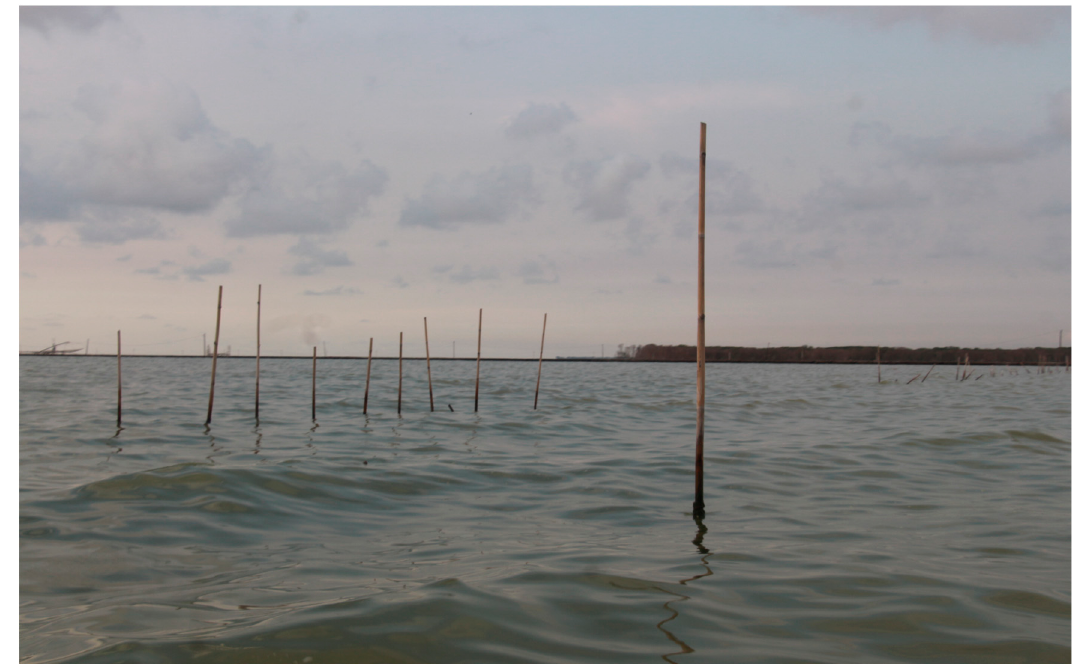
Figure 4. First type of inundated land. The inundation depth can reach up to 6 m. Some of landowners use the bamboo stack to mark their land boundary. Its location is too close to the open sea, making it unsuitable for fish breeding. Source: field data collection.